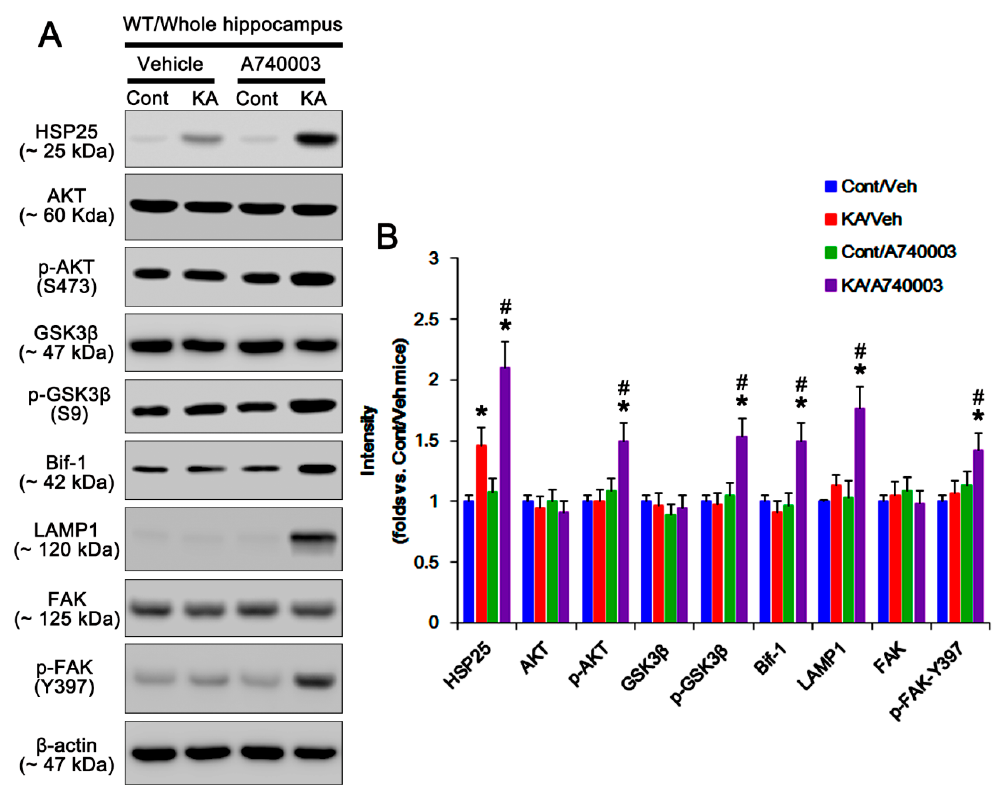
Figure 3. Effects of A740003 on expressions and phosphorylations of HSP25, AKT, GSK3 β , Bif-1, LAMP1, and FAK in the whole hippocampus obtained from WT mice following KA injection. ( A ) Representative Western blot of expressions and phosphorylations of HSP25, AKT, GSK3 β , Bif-1, LAMP1, and FAK. Cont, control animals; KA, KA-injected animals. ( B ) Quantifications of expressions and phosphorylations of HSP25, AKT, GSK3 β , Bif-1, LAMP1, and FAK in KO astrocytes following KA injection (mean ± SEM; * ,# p < 0.05 vs. control and vehicle-treated mice, respectively; n = 7, respectively).